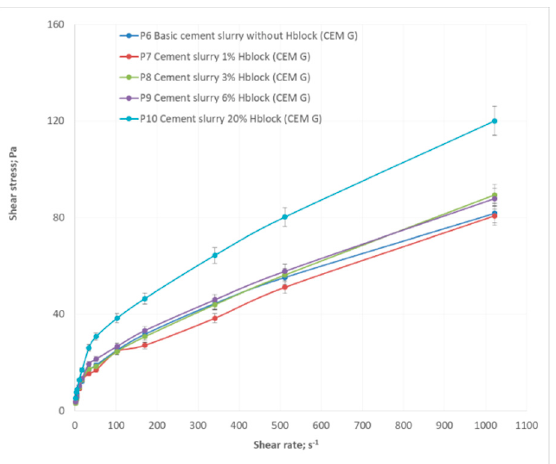
Figure 19. Flow curves for cement slurries with the addition of Hblock (cement class CEM G).